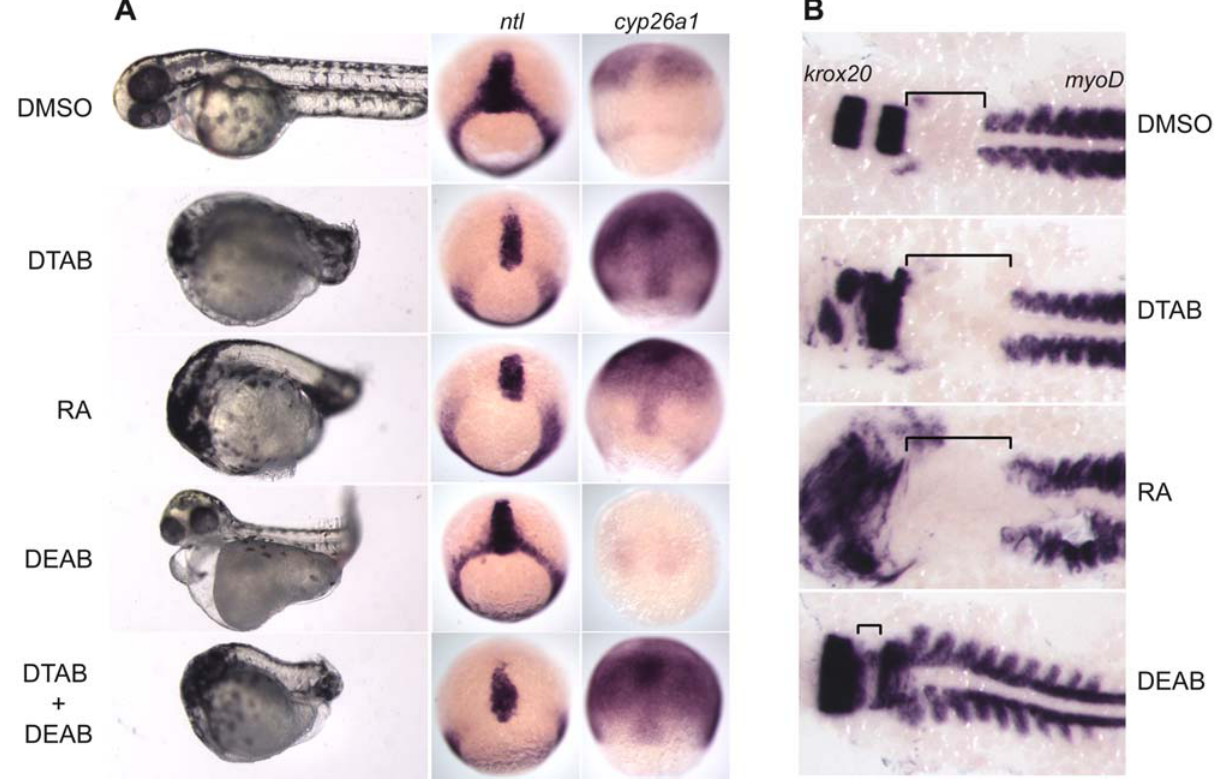
Figure 4. DTAB mimics effects of RA on early development. a) Treatment with DTAB, RA and DTAB + DEAB results in anterior-posterior shortened phenotype. DEAB alone caused pericardial edema, twisted body axis and downregulation of cyp26a1 . DEAB treatment did not affect the ntl staining while RA and DTAB treatment led to a loss of ntl staining in the dorsal margin. DTAB, RA and DTAB + DEAB caused an increase in cyp26a1 staining but DEAB alone caused downregulation of cyp26a1 . Embryos were treated with DTAB (12.5 m M), RA (1 m M), DEAB (10 m M) and DTAB + DEAB or DMSO from 1hpf to 48hpf (for the bright field photography) and to 70% epiboly (for in situ hybridization for ntl and cyp26a1 ). Live bright field embryos are shown anterior to the left and dorsal to the top. In situ hybridized embryos, are shown, dorsal view with the animal pole to the top. b) DTAB and RA treatment caused an expansion in the distance between the krox20 and myoD positive domains. DEAB caused a compression of the ‘neck’ region and led to a decrease in the distance between krox20 and myoD domains. Embryos treated with DMSO, DTAB (1.6 m M), RA (0.125 m M) and DEAB (10 m M) were fixed at 9-somite stage and hybridized for krox20 (rhombomeres 3 & 5) and myoD (somites). Following in situ hybridization the embryos were de-yolked and flattened under a coverslip for better